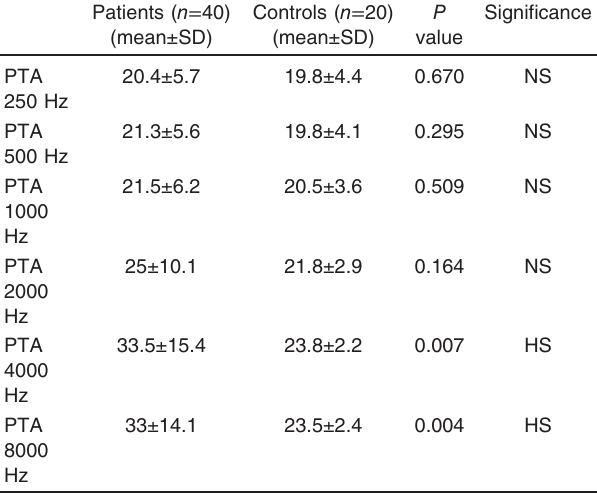
Table 1 Mean±SD of hearing threshold levels of rheumatoid arthritis patients and the control group in the right ear